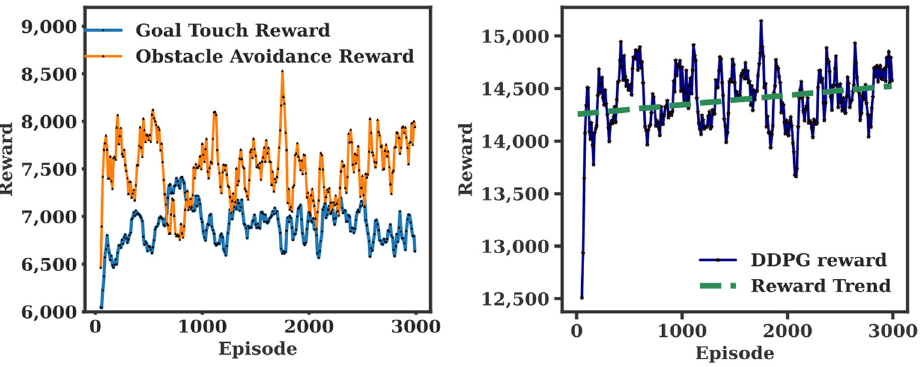
Figure 4. Path planning and obstacle avoidance by HAM.